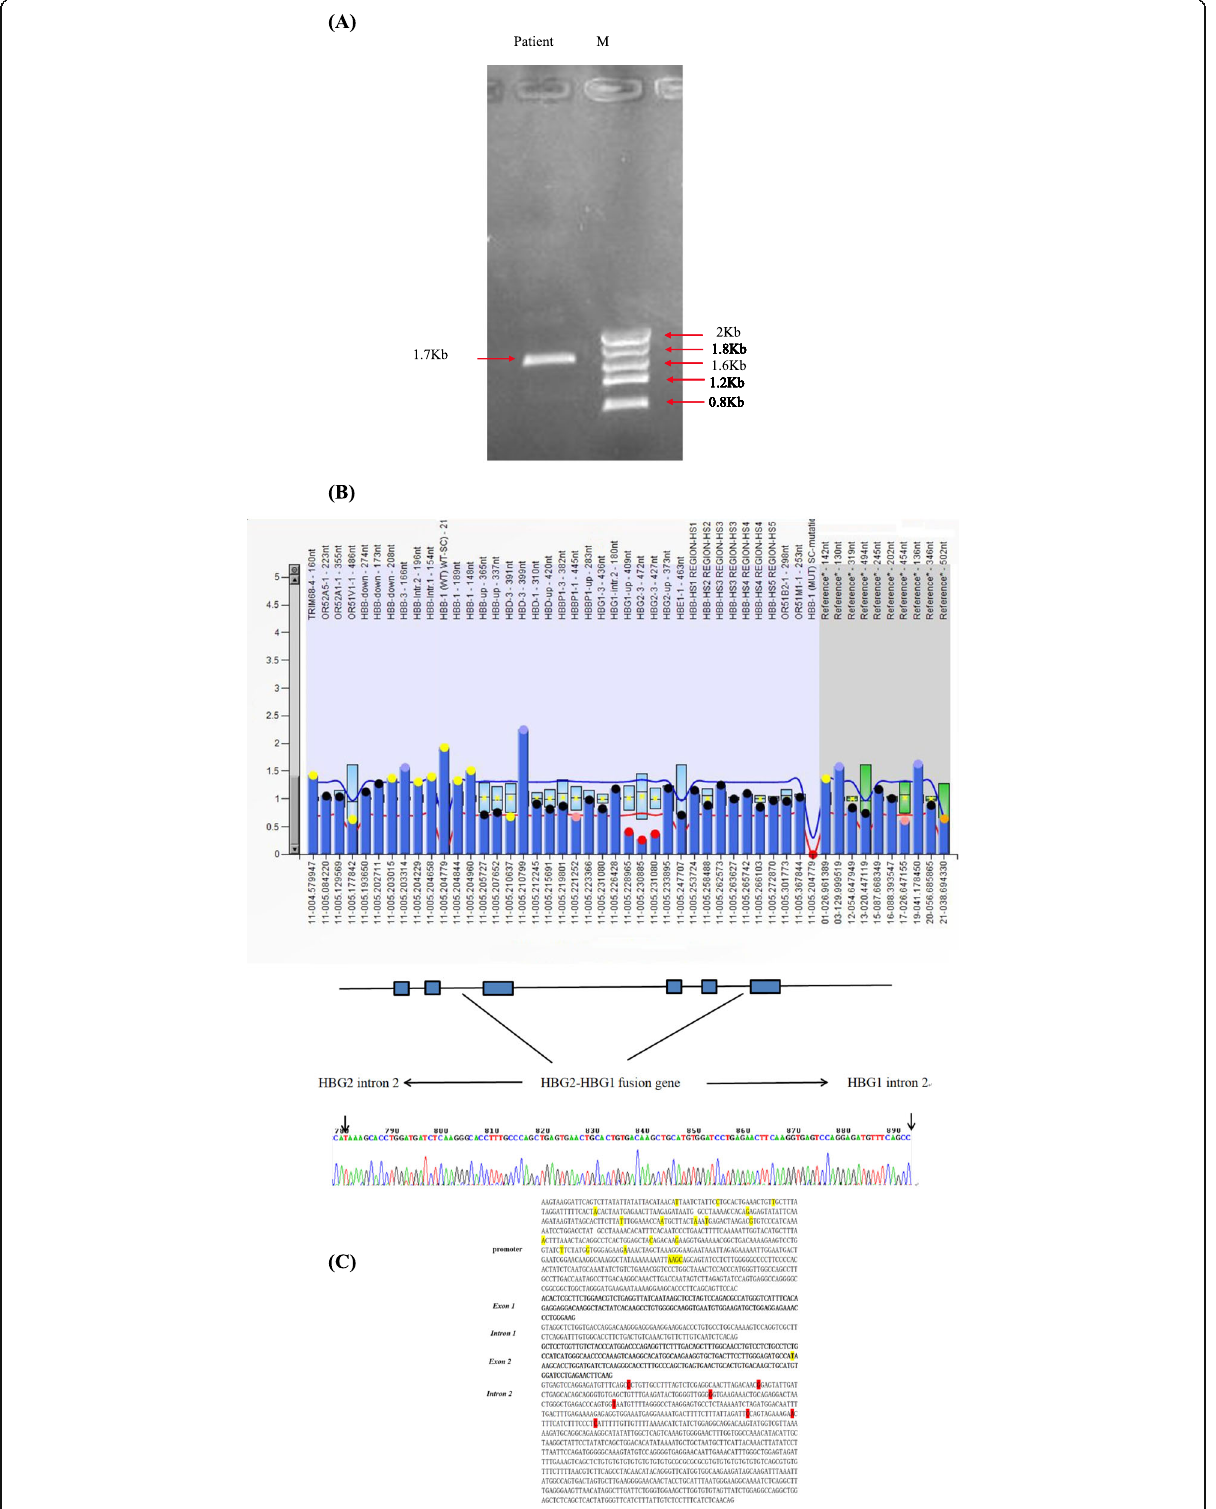
Fig.6 (See legend on next